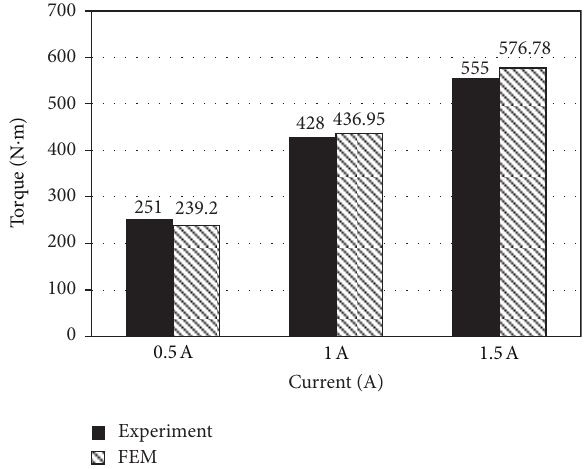
Figure 14: Comparison of the analytical and experimental damping torque